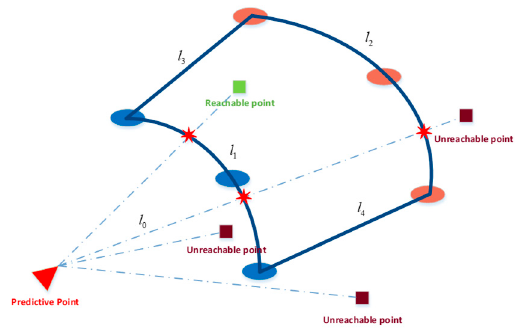
Figure 4. The reachability discrimination schematic for the new